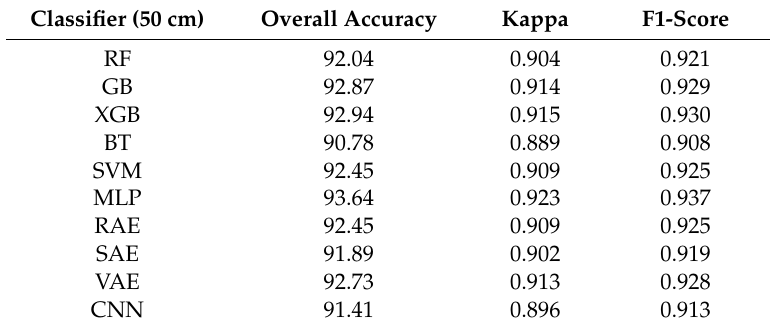
Table 3. Accuracy measures derived from the models applied on the 50 cm